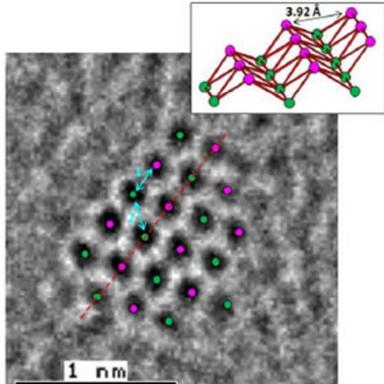
ACAT TEM image of an individual Pt cluster after 700 °C reduction. Each Pt atom is registered to alumina plane, with the green atoms below the pink atoms. Reprinted with permission from Copyright 2015 John Wiley and Sons.